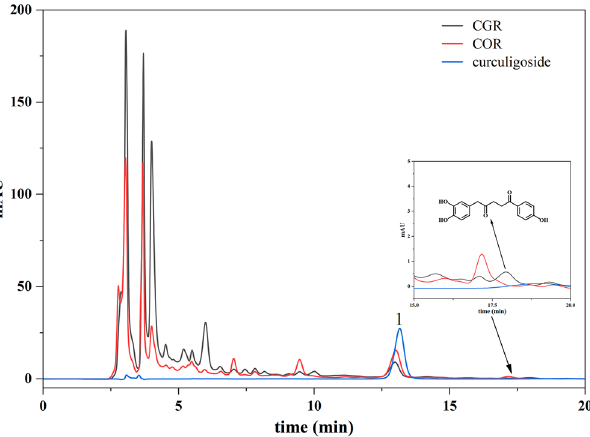
Figure 2. High-performance liquid chromatography (HPLC) chromatogram of curculigoside, COR and CGR samples. Peak 1: curculigoside.